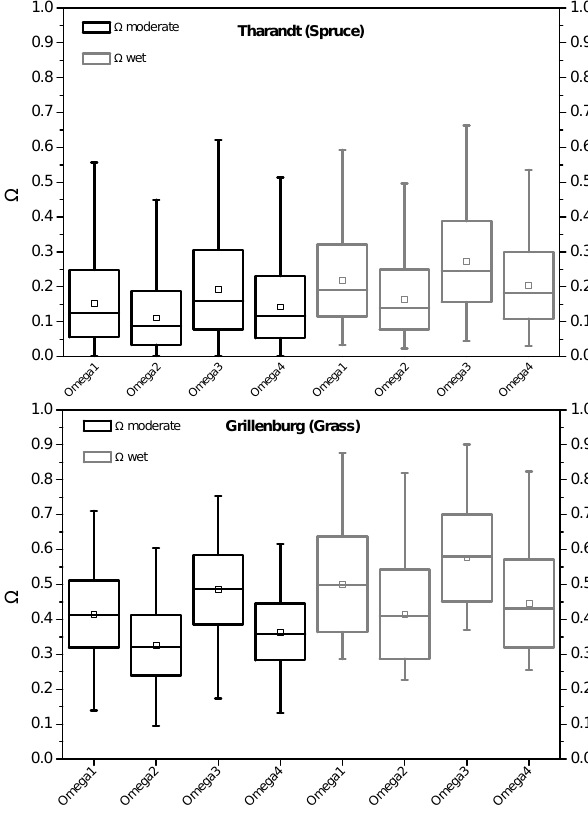
Fig. 4. Decoupling coefficient derived from measurements (half hour means) at the Anchor Station Grillenburg (grass, panel above) and Tharandt (spruce, panel below) during the summer season 2007 (for further information see caption of Fig.